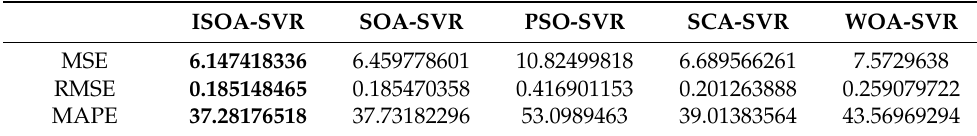
Table 11. The results of MSE, RMSE and MAPE of five models in Experiment 2.